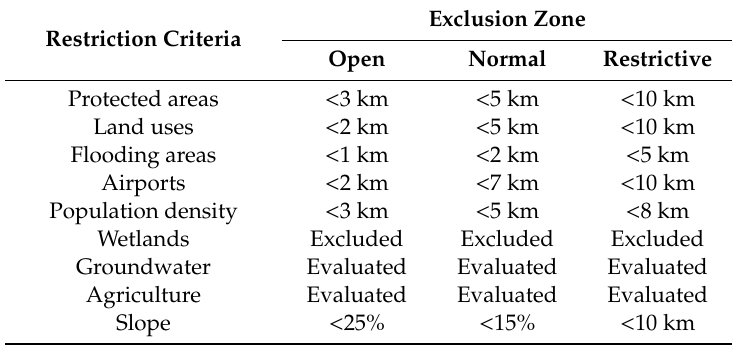
Table 4. Restriction criteria standardization values.